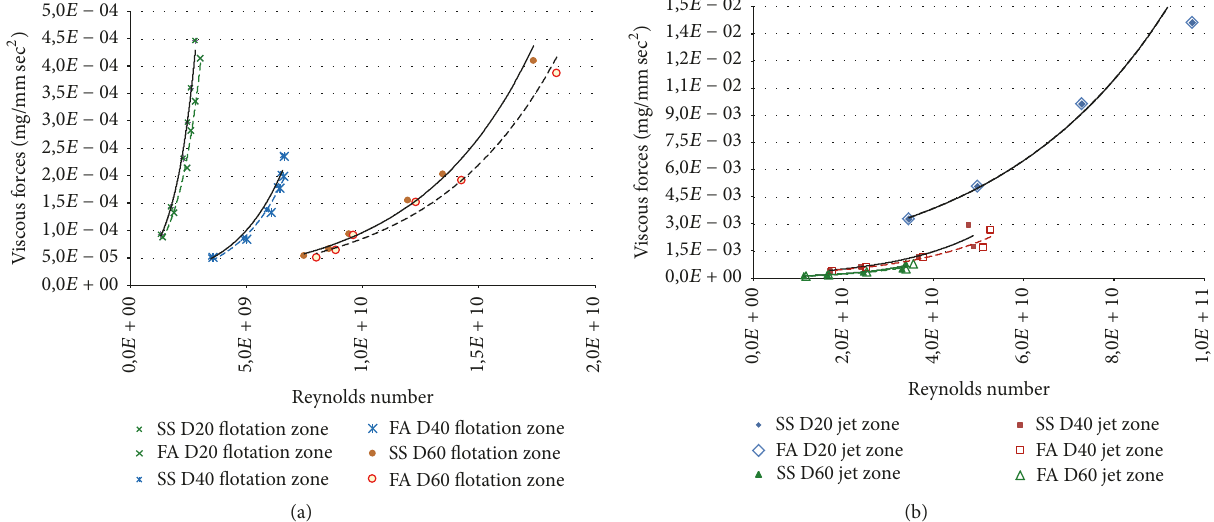
Figure 6: Viscous forces as a function of Reynolds number of bubbles in flotation tank. (a) Viscous forces at the flotation zone and (b) viscous forces at the jet